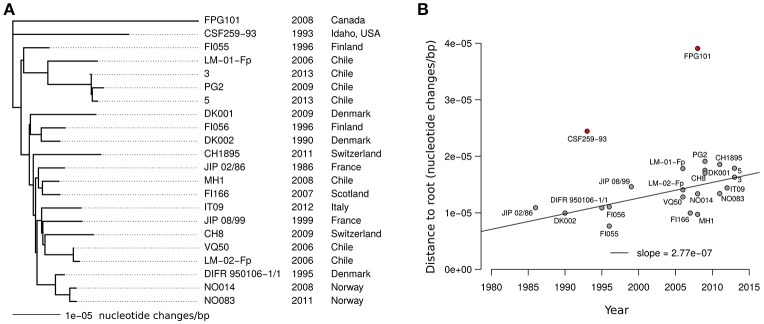
Tree built on mutational distances within CC-ST10. (A) Neighbor-Joining tree for CC-ST10 built on the estimated number of mutations (m). (B) Tip to root distance as a function of isolate sampling year. The line represents the linear regression obtained after excluding the two isolates of North-American origins (shown in red).